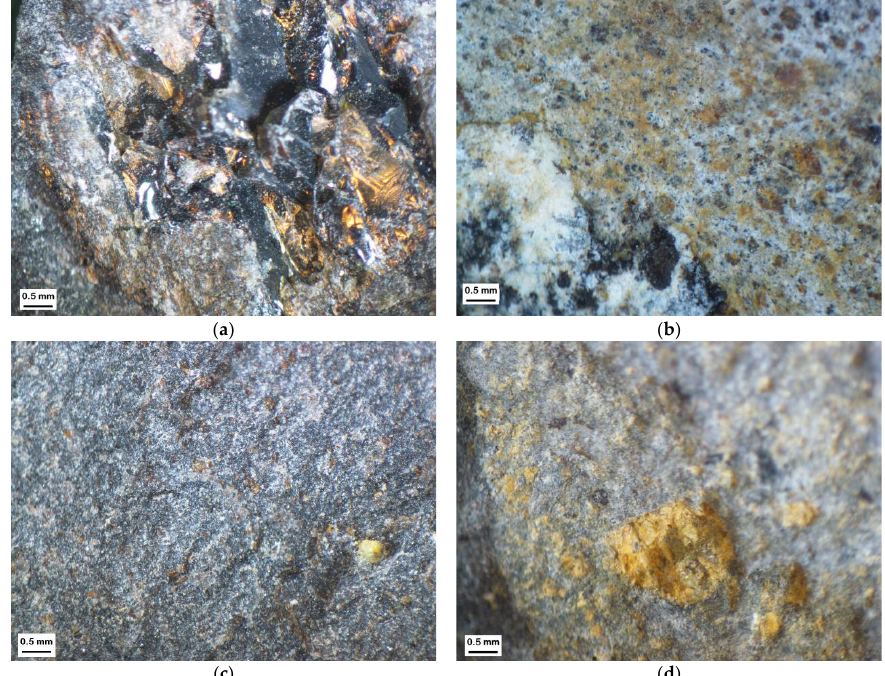
Figure A9. Characteristics of cracks in samples after crushing in jaw crusher (feed — non-flaky grains): ( a ) Basalt aggregate 1, non-flaky grains, +8 mm; ( b ) Basalt aggregate 1, non-flaky grains, +16 mm; ( c ) Basalt aggregate 1, flaky grains, +8 mm; ( d ) Basalt aggregate 1, flaky grains, +16 mm.